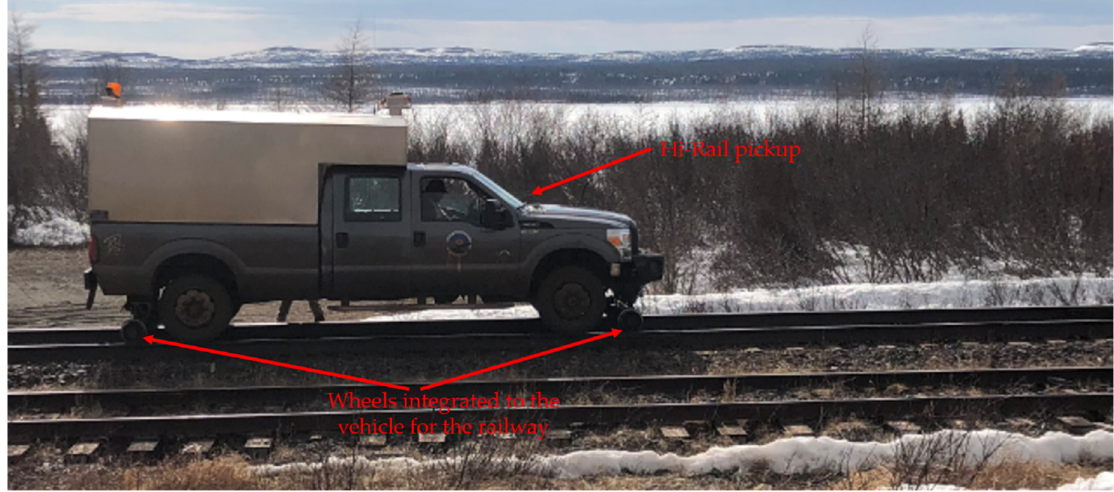
Figure 4. Hi-Rail pickup from Tshiuetin company in northern Quebec.